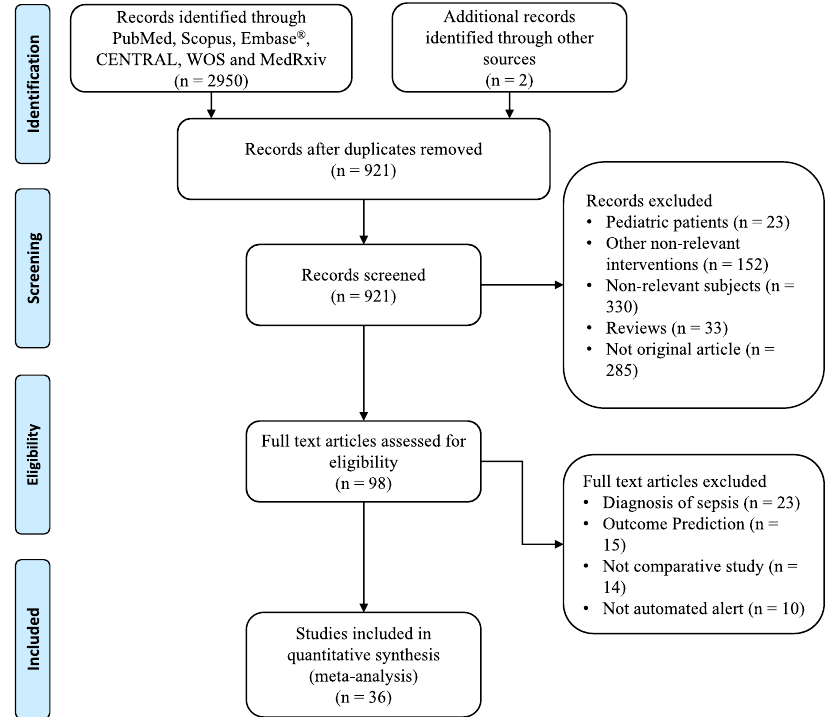
Fig. 1 Flowchart of study selection. WOS web of science, CENTRAL Cochrane Central Register of Controlled